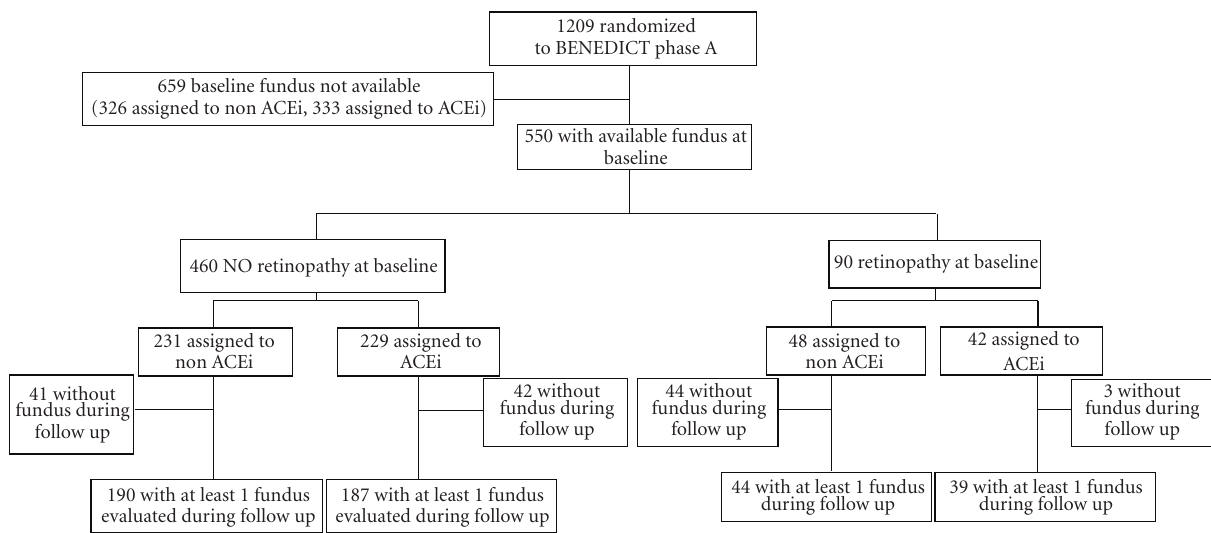
Figure 1: Study flow chart.